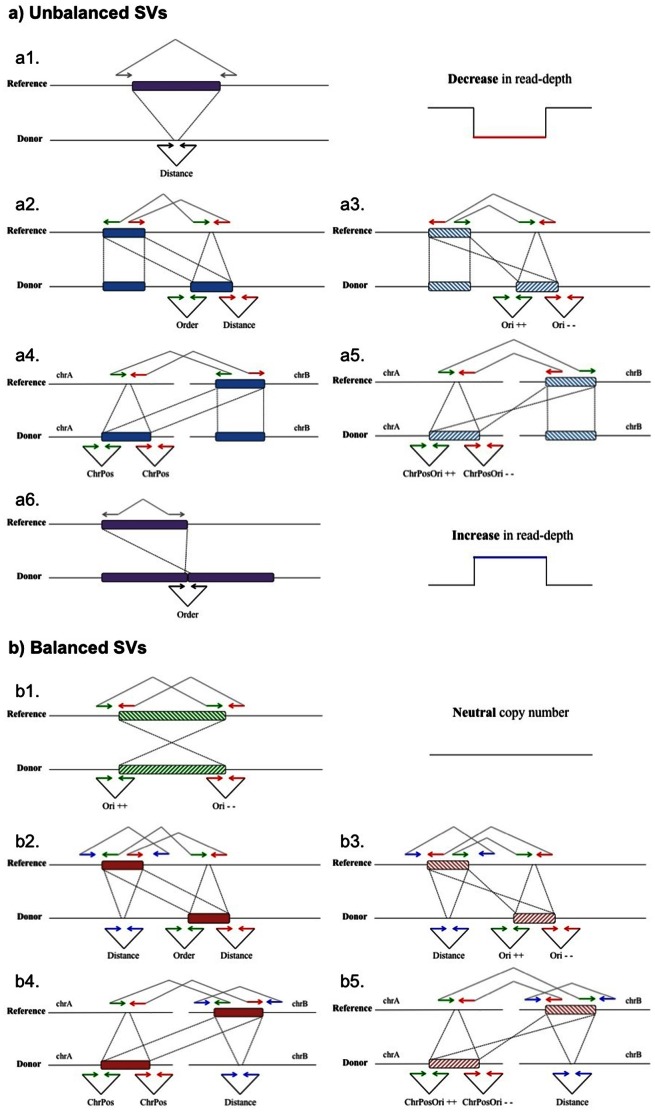
Combination of different types of anomalous read-pair alignments together with read depth (RD) pattern to define four different categories of structural variants (SVs).Case a.1 plus a decrease in RD represents a deletion. Cases a.2, a.3, a.4, a5 and a.6 together with an increase in RD represent different types of copy number gains in terms of the co-localization of the copy. Cases a.2 and a.3 represent a copy inserted within the same chromosome, were in case a.3 the copy is inserted in an inverted orientation. Analogous cases a.4 and a.5 represent straight or inverted insertions of copies in another chromosome. Case a.6 represents tandem duplications. Case b1 corresponds to an inversion. Cases b2 and b3 correspond to an intra-chromosomal translocation, but in case b3 the translocated region is inserted in inverted orientation. Similarly cases b4 and b5 correspond to inter-chromosomal translocations.